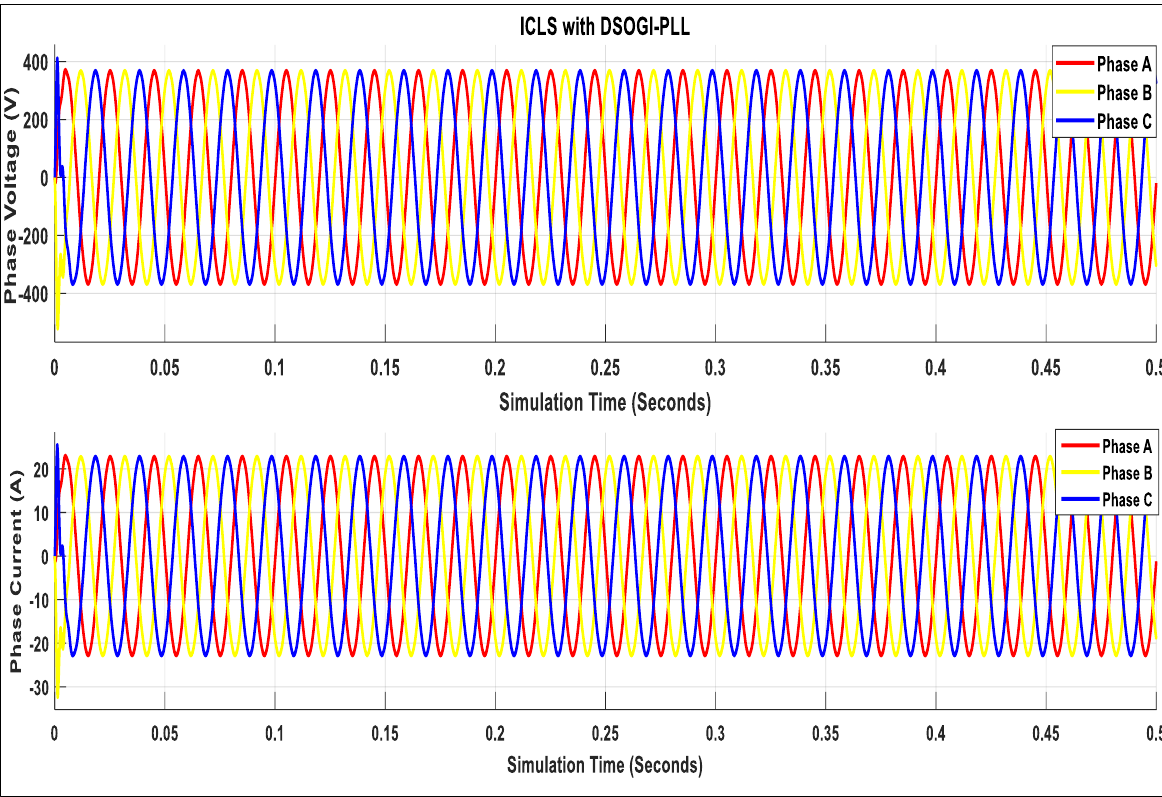
Figure 9. Case study 1 three-phase grid voltages and current with ICLS-DSOGI-PLL.